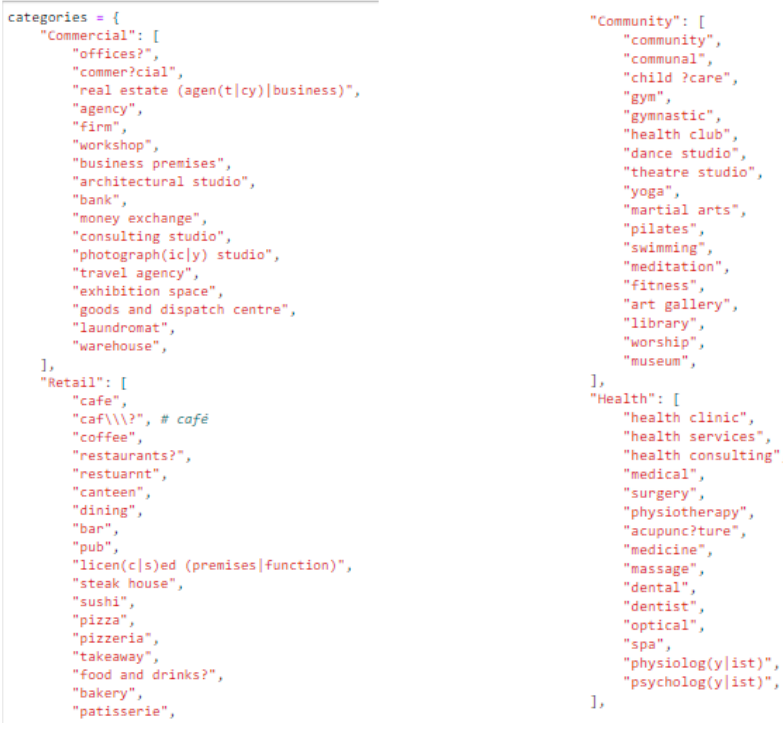
Figure 13. List of categories and uses included in each category.